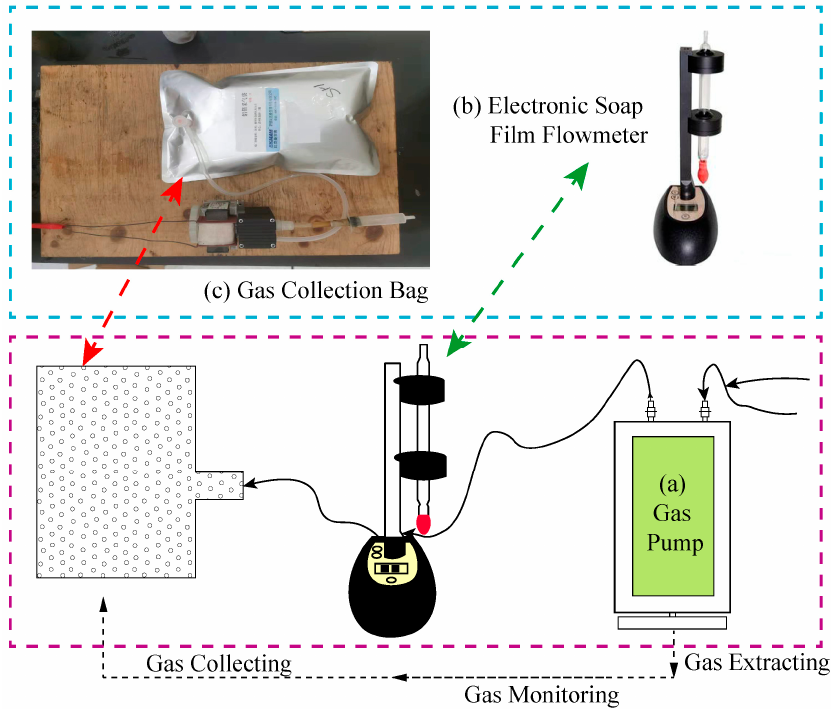
Figure 5. Gas collection and monitoring device.